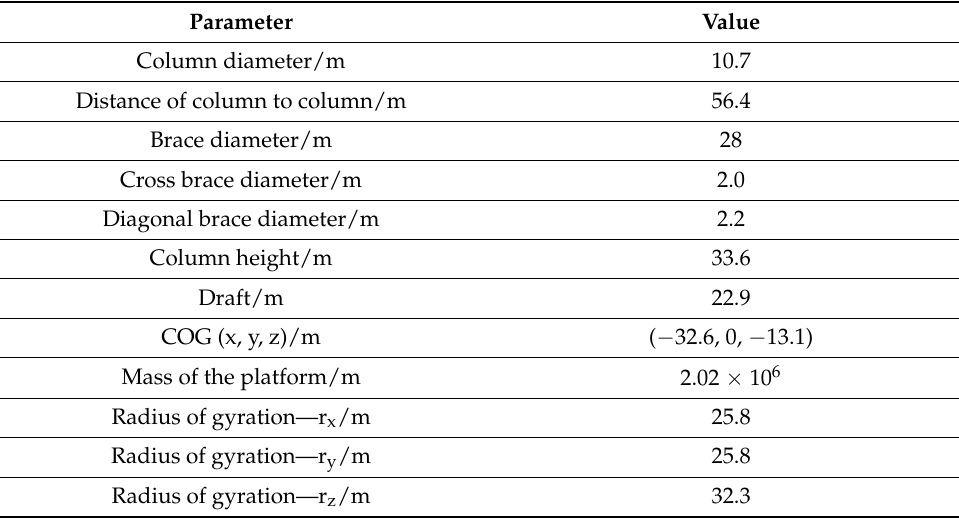
Table 2. Properties of the WindFloat semisubmersible floating